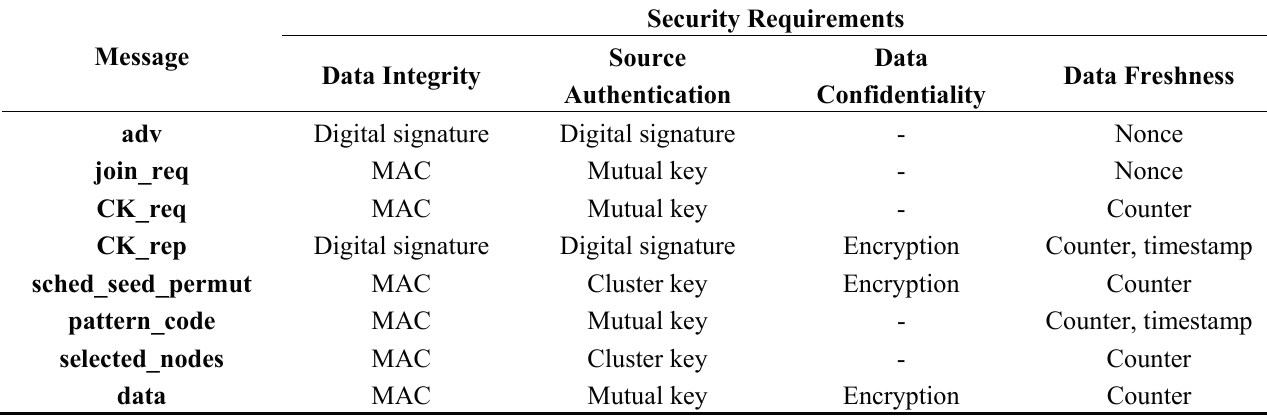
Table 2. Protocol security requirements